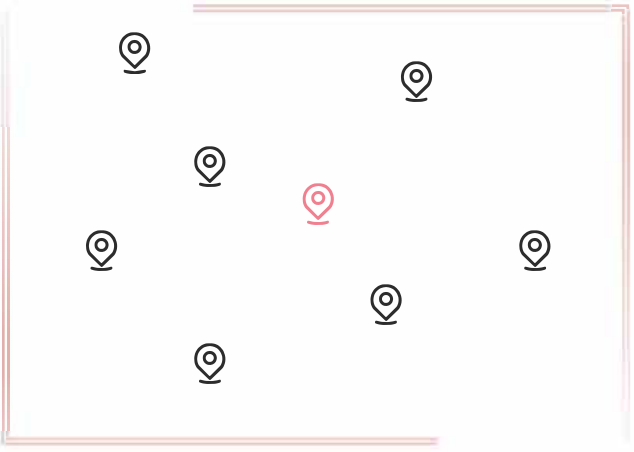
Figure 5. A cloaking area with k = 8